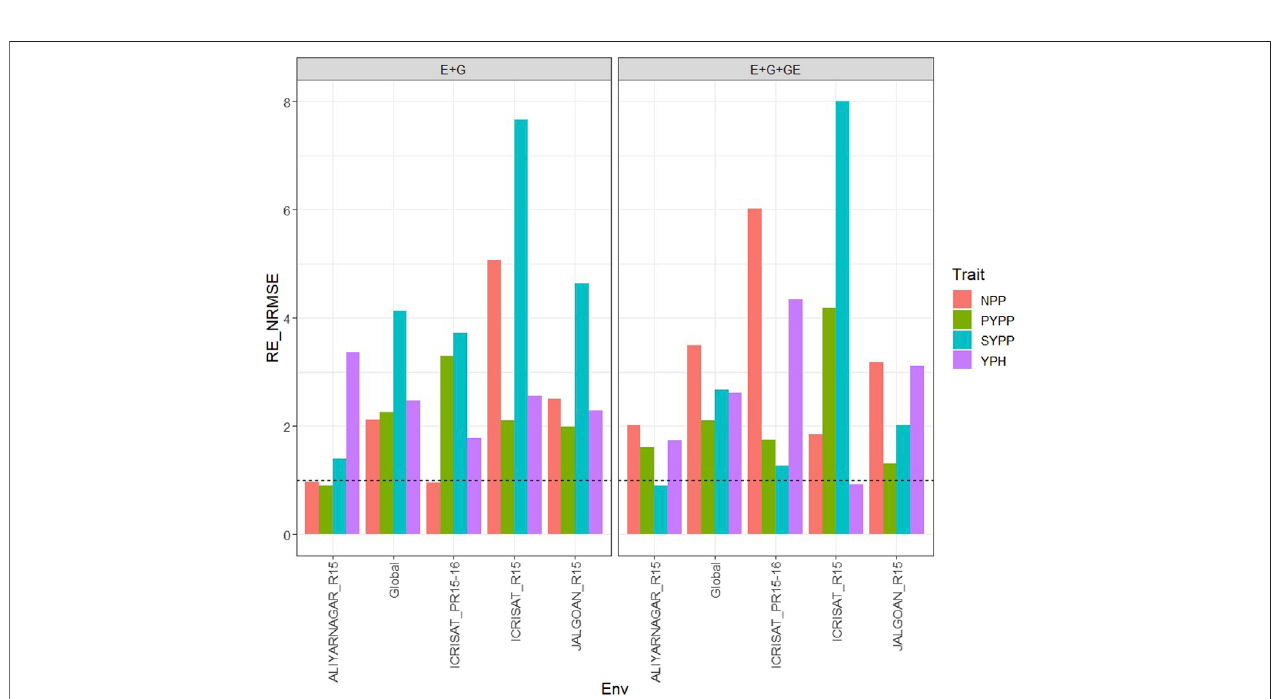
FIGURE 4 | Relative ef fi ciency in terms of normalized root mean square error (RE_NRMSE) computed by dividing the NRMSE under the best linear unbiased predictor model (GBLUP) between the NRMSE of the partial least squares regression method. Prediction performance is reported for each environment and across environments (Global) in dataset 4 (Groundnut), also with two predictors (E + G and E + G + GE). When the RE_NRMSE > 1, the PLS outperforms the GBLUP method in terms of prediction performance (lower NRMSE).